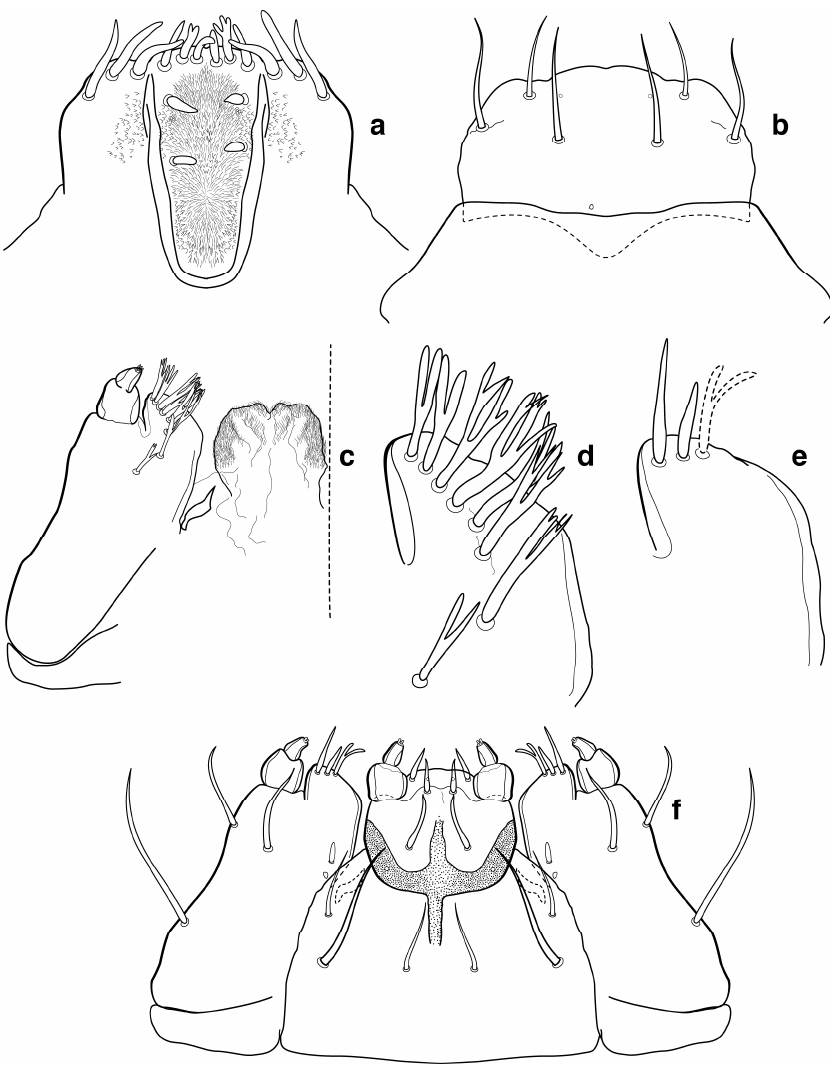
Figure 76. Rhabdoscelus prob. obscurus mouthparts: ( a ) epipharynx; ( b ) clypeus (incomplete) and labrum; ( c ) maxillae and hypopharynx, dorsal view; ( d ) detail of mala and dorsal malar setae; ( e ) detail of mala and ventral malar setae; and ( f ) labio-maxillary complex, ventral view. Diversity 2018 , 10 , x FOR PEER REVIEW